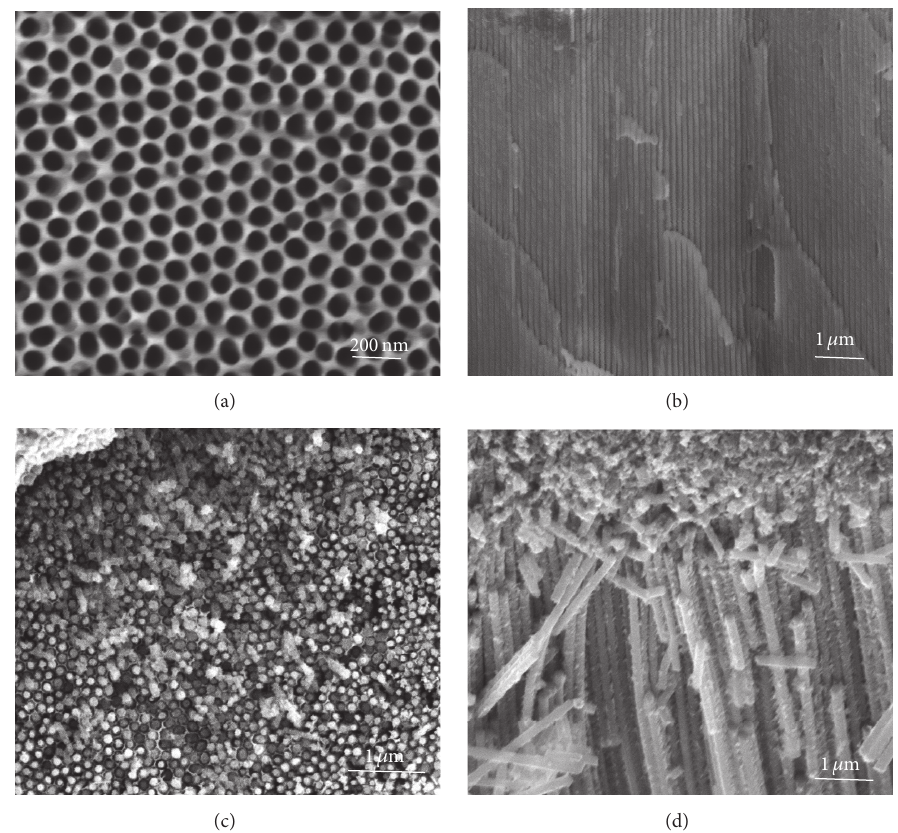
Figure 1: ((a), (b)) The top-view and cross-sectional SEM images of the AAO template, (c) the top-view SEM image of the mesoporous SnO 2 nanowires, and (d) the profile SEM image of the mesoporous SnO 2 nanowires after AAO template removal.